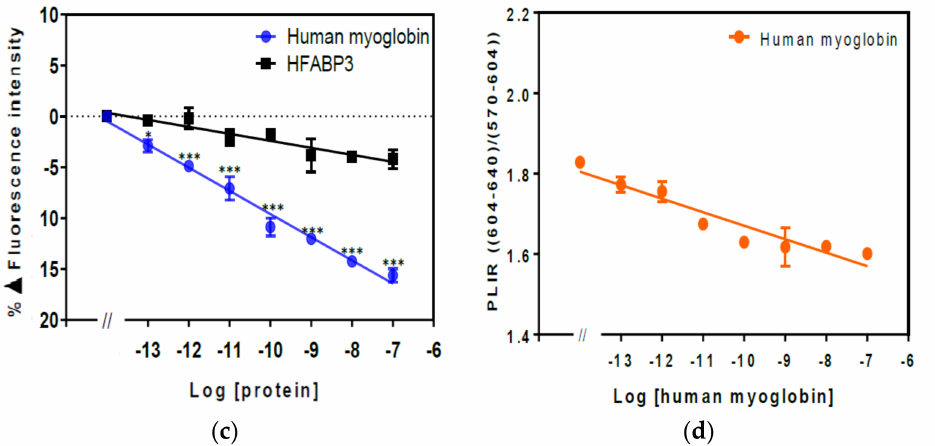
Figure 5. Fluorescence intensity spectra of Eu 3+ chelated by PMDA modified anti-human myoglobin Affimer complex in 1% ( v / v ) human serum. Fluorescence was measured at 590 and 615 nm with λ ex = 395 nm. ( a ) Fluorescence intensity spectra of Eu 3+ chelated PMDA modified anti-human myoglobin Affimer; ( b ), fluorescence intensity spectra of the same complex after HFABP3 (control) added; ( c ) percentage change in fluorescence intensity; ( d ) photoluminescence intensity ratio. Data are means ± SEM (n = 4). Some error bars are smaller than data points (*, ** and *** indicate significance with p -value < 0.05, 0.01, and 0.001 respectively of the specific analyte (human myoglobin) compared to the control (HFAPB3)